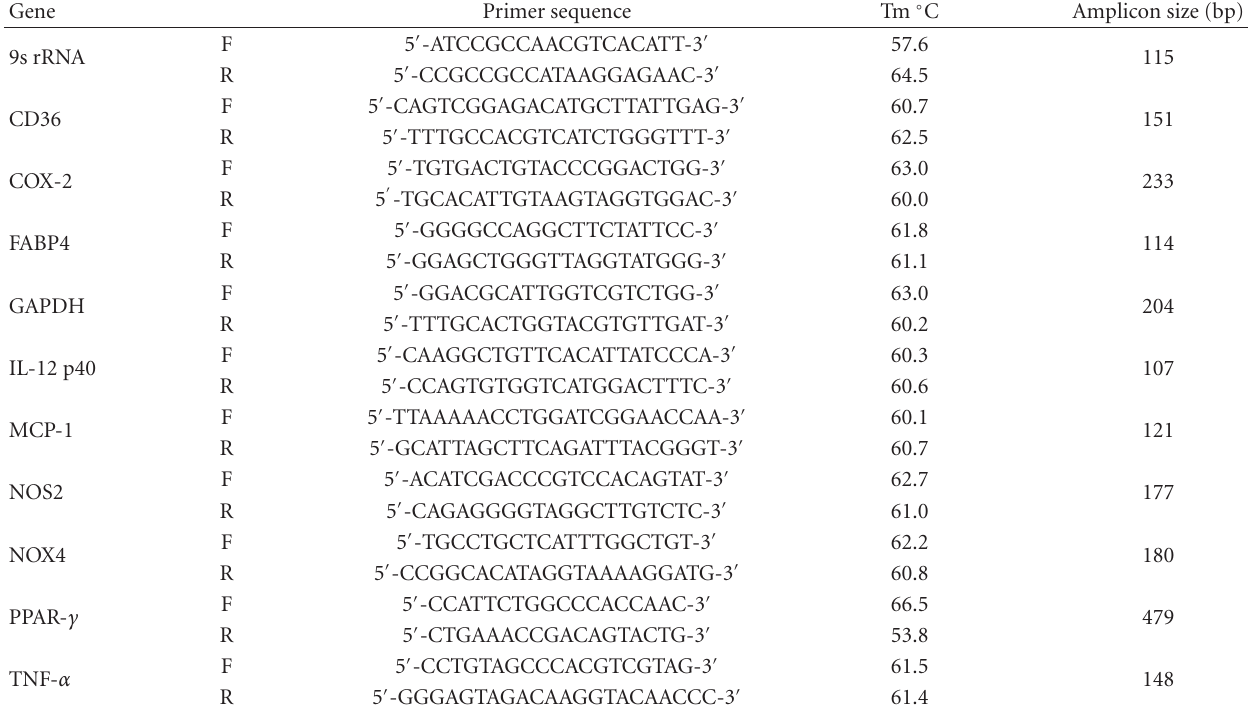
Table 1: Oligonucleotide primers